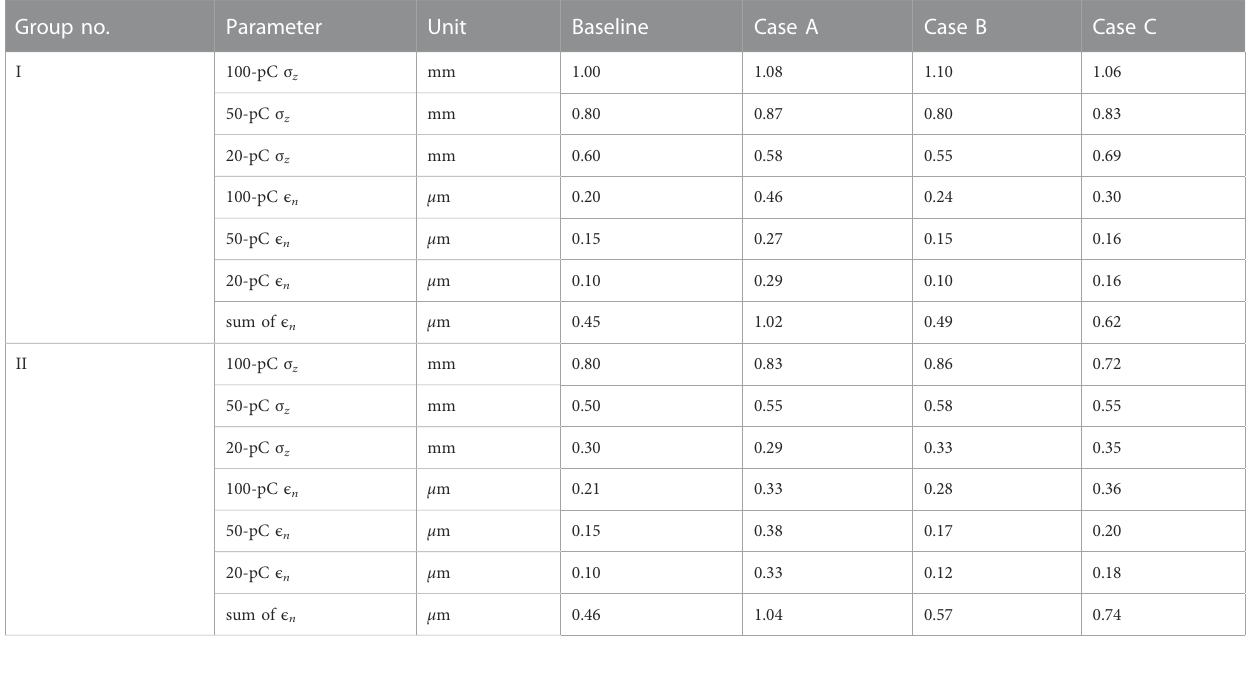
TABLE 2Electron bunch length andthe corresponding optimalemittanceof threebeam chargesin the baseline andthree multiplexed con fi gurations. Case (A) no customization of parameters for the three bunch charges; case (B) customization of the laser spot size for each charge; and case (C) customization of laser pulse duration for each charge. Details see the text.